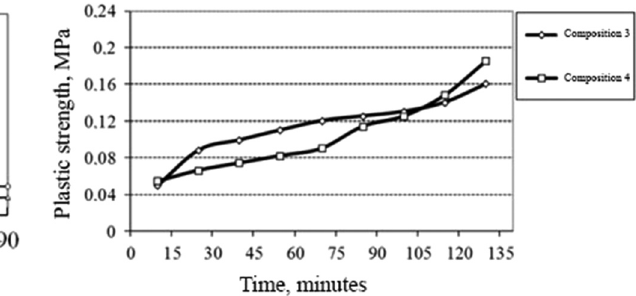
Figure 10: Change in the fl owability of cement pastes with CNTs and GBFS ( composition No. 2 ) and without CNTs ( composition No.1 ) over time.